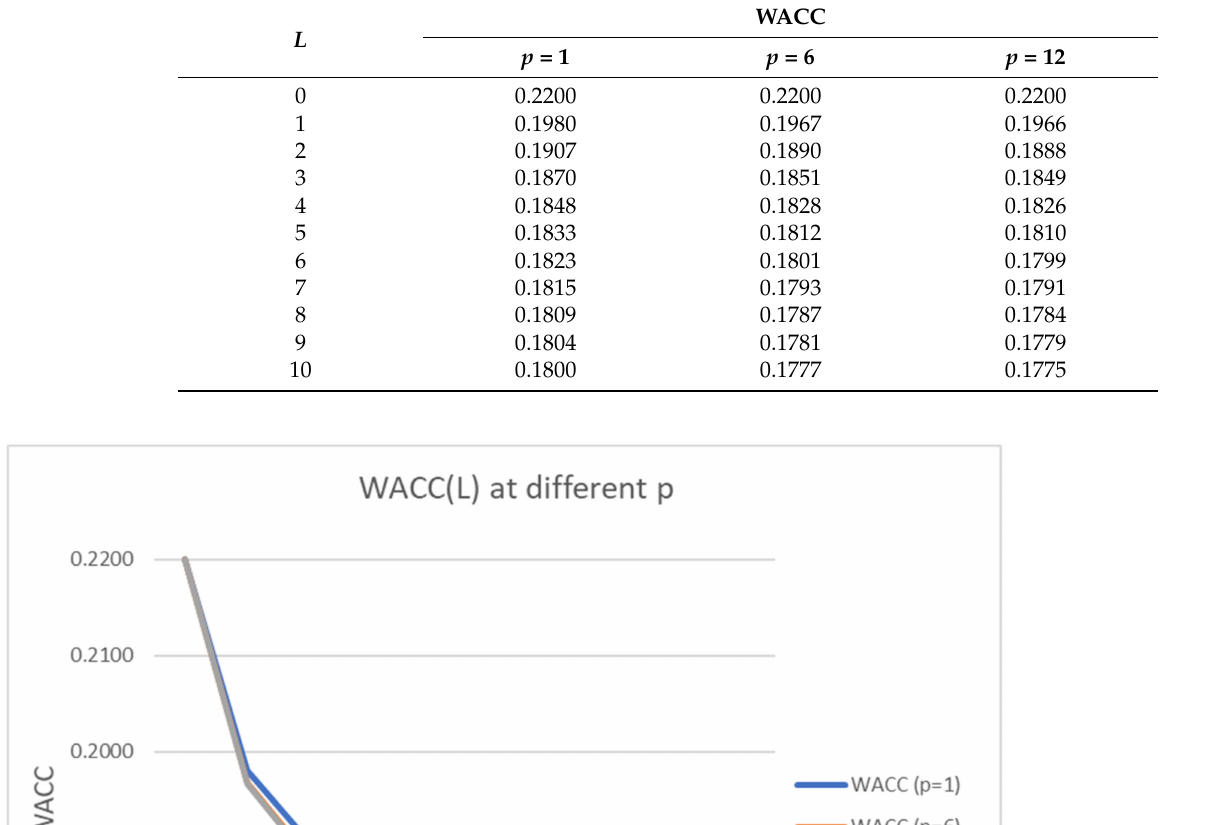
Table 1. Dependence of WACC on leverage level L at k 0 = 0.22, k d = 0.14 and different p = 1, 6, 12.